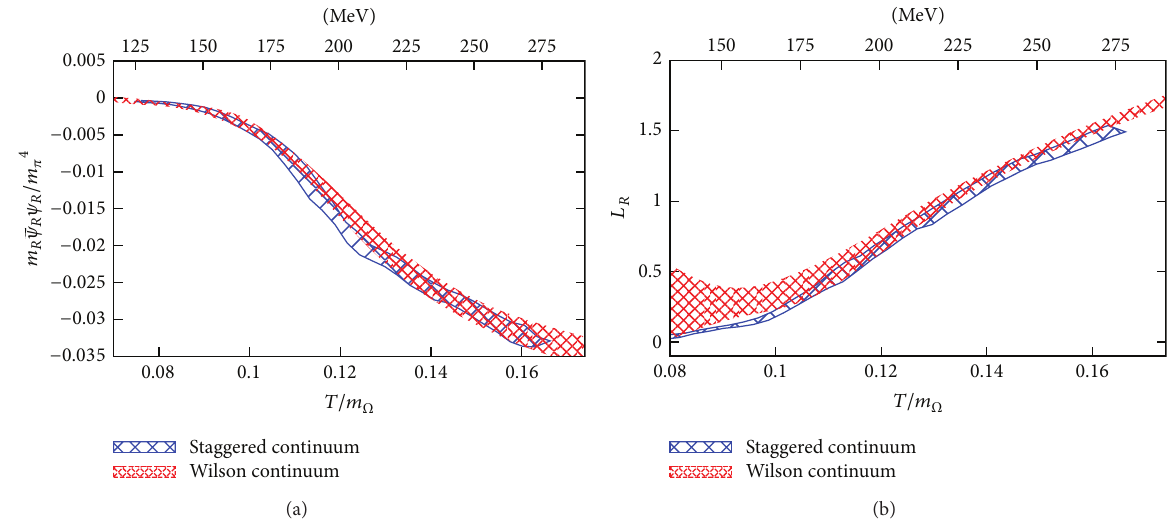
Figure 6: The continuum extrapolated renormalized chiral condensate (a) and the Polakov loop (b) are compared for Wilson and stout- smeared staggered fermions, from